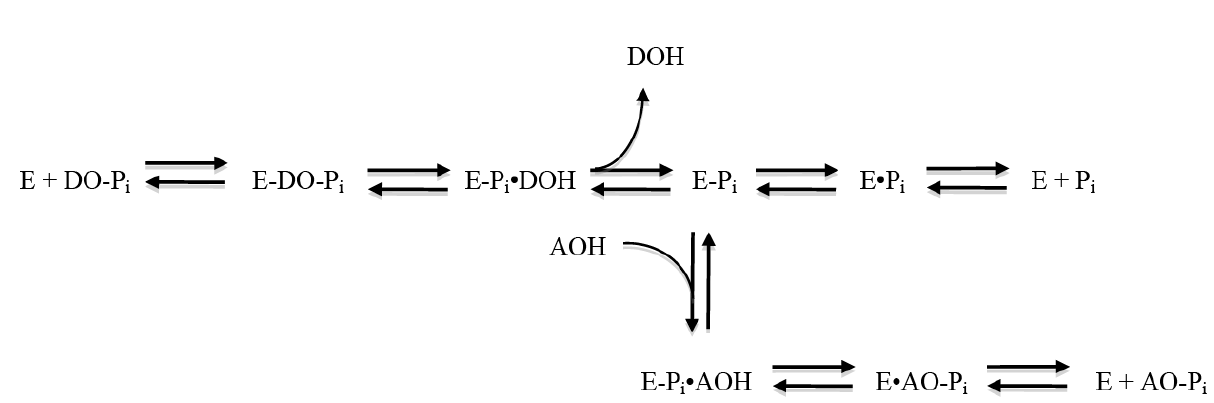
Figure 1. Catalytic mechanism of the alkaline phosphatase reaction (see [34]). E, alkaline , substrate molecule; E-P , phosphoenzyme (enzyme phosphatase enzyme molecule; DO-P i i phosphorylated on Ser-93 in the TNAP sequence of its active site); DOH, product alcohol; , noncovalent complex of inorganic phosphate in the active site; AOH, an alcohol E ⋅ P i molecule, acceptor substrate of transphosphorylation reaction acceptor; AO-P , product of i transphosphorylation